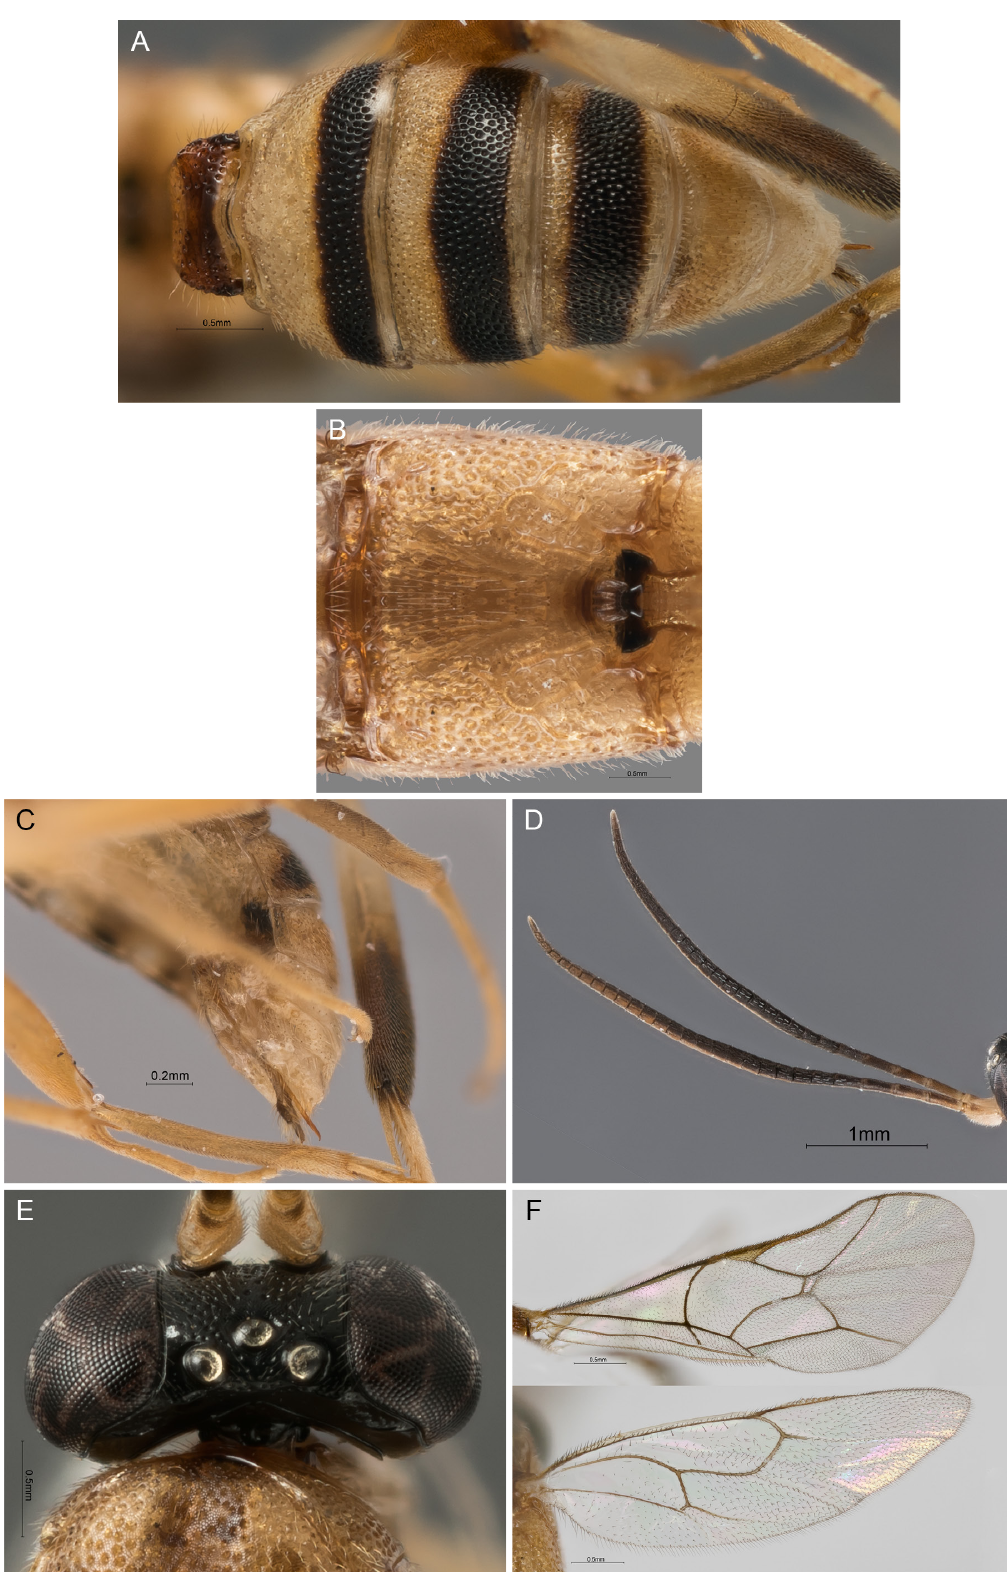
Fig. 27. Palpostilpnus singaporensis sp. nov., holotype, ♀ (LKCNHM). A . Metasoma, dorsal view. B . Propodeum, dorsal view. C . Ovipositor. D . Antennae. E . Vertex. F .